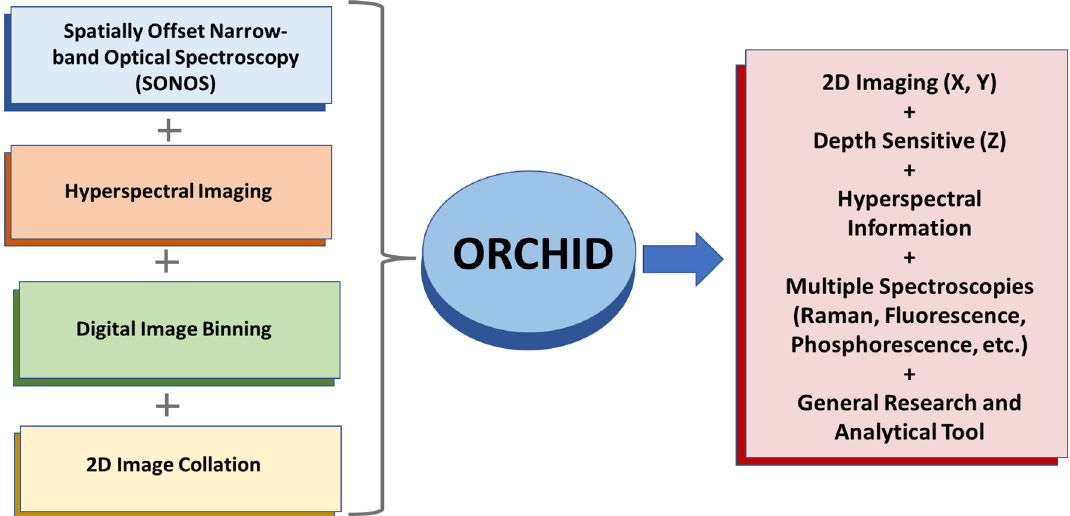
Figure 1. Schematic diagram of the ORCHID concept. The ORCHID system integrates several layers of instrumental systems and processing. Spatially offset methods consist of techniques that are used to selectively collect signal from deeper layers. Hyperspectral imaging integrates the spatial information collected from this method with spectral information to produce an information rich multidimensional dataset. Digital Image Binning and 2D Image Collation complete the system by integrating post processing techniques and stitching to produce a hyperspectral data cube that can be used to collocate signals with positions on the